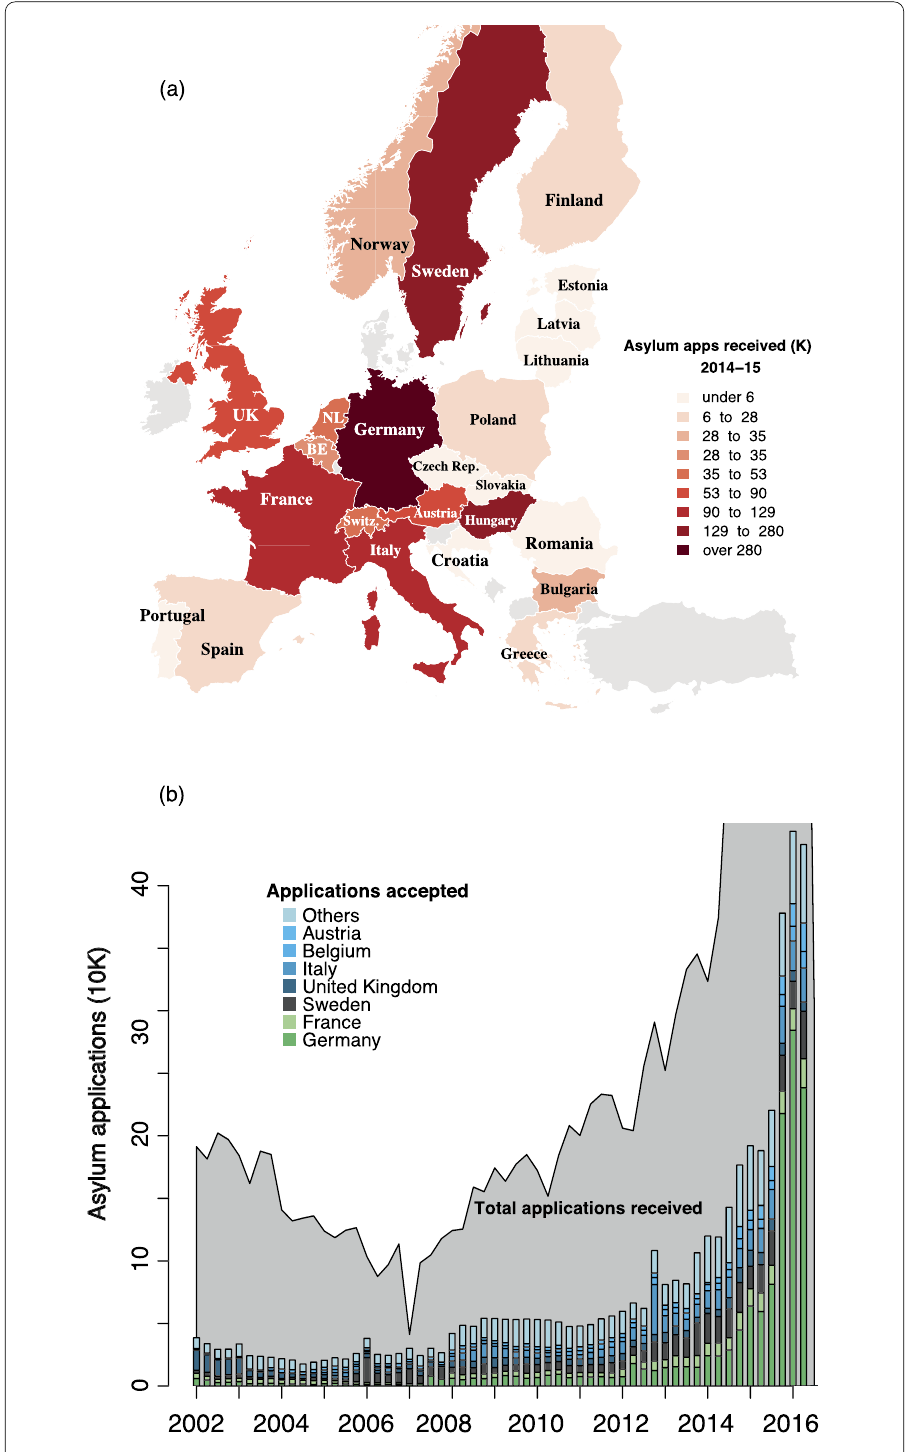
Figure 1 Graphical illustration of our European asylum data. ( a ) Distribution of asylum applications across Europe: red shades indicate the number of applications received at the height of the ‘refugee crisis’ in 2014–15. ( b ) Quarterly time series of applications received 2002–2016. Gray shading indicates the total number of first-time asylum applications received by the 20 European countries included in our study. Only countries that accepted substantial proportions of asylum seekers are shown in stacked